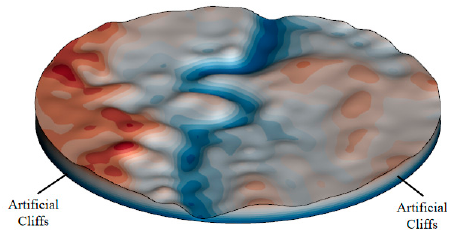
Figure 1. Schematic diagram of Artificial Cli ff